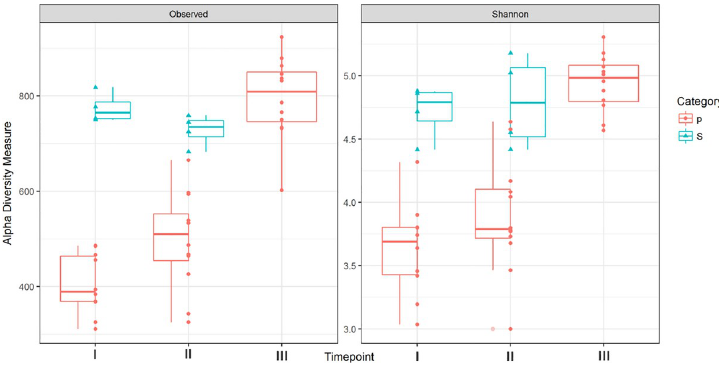
Fig 1. Box plot of observed OTUs abundances and Shannon index values. Category: p = piglets, S = sows. Timepoint: I = day 7 post-farrowing, II = day 14 post-farrowing, III = day 14 post-weaning.